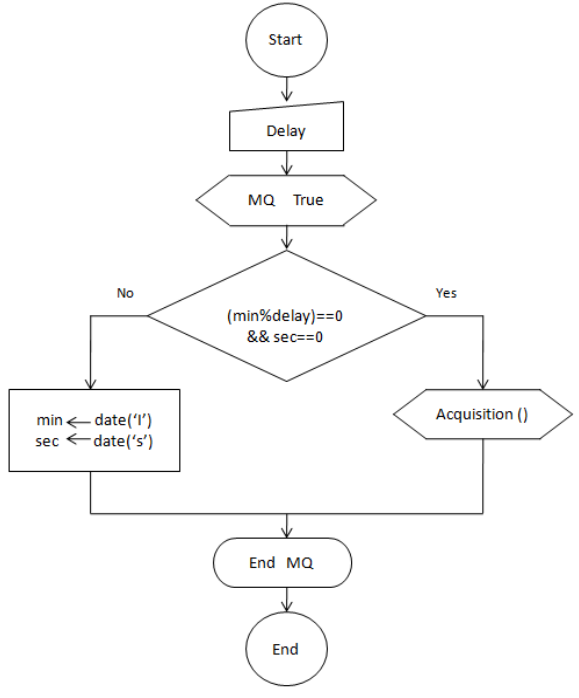
Figure 11. Flow diagram for the data transmission request in the central